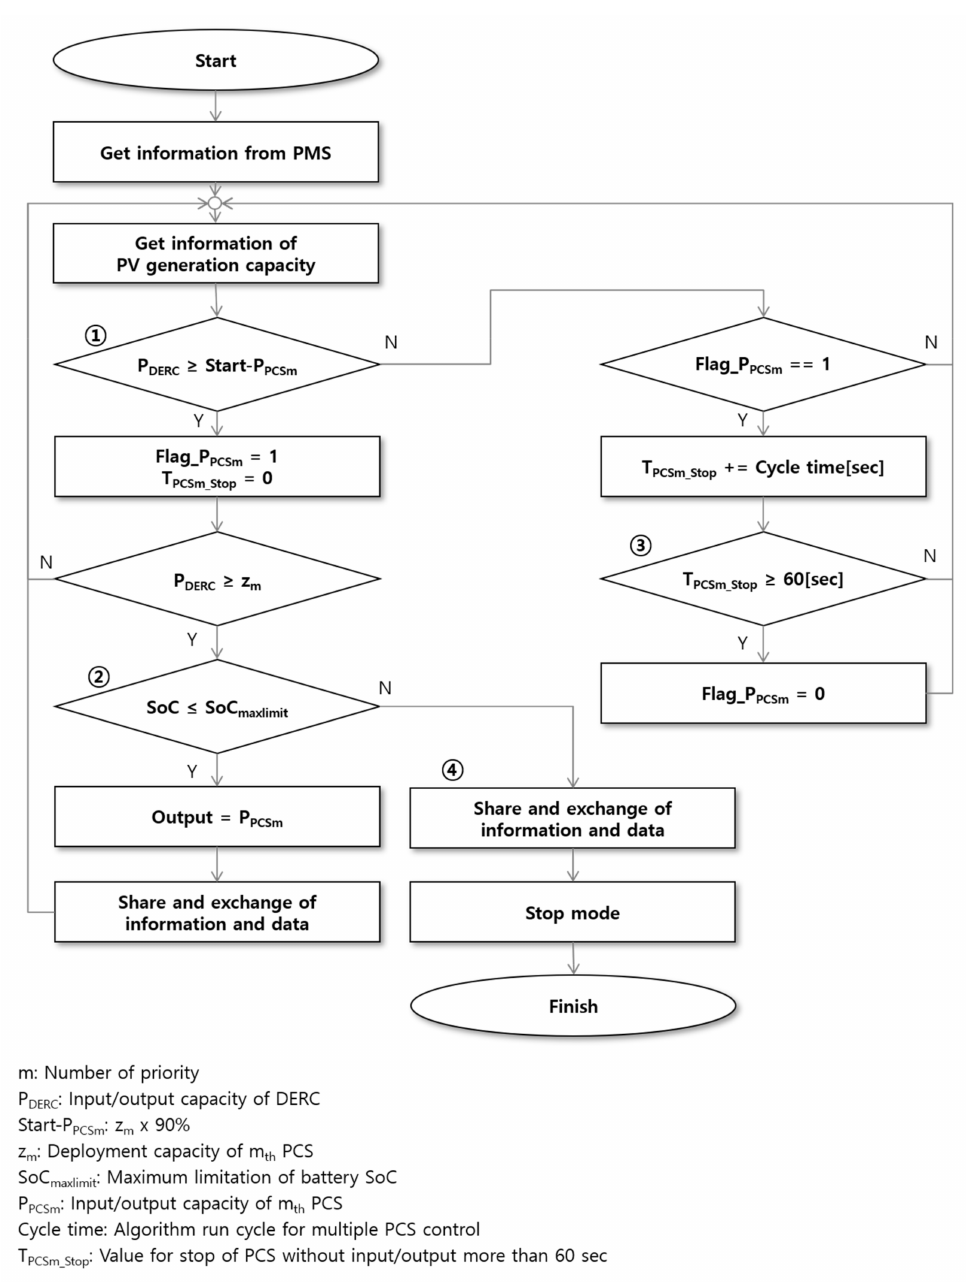
Figure 10. The flowchart for the multiple PCS control scheme of a DERC (charging